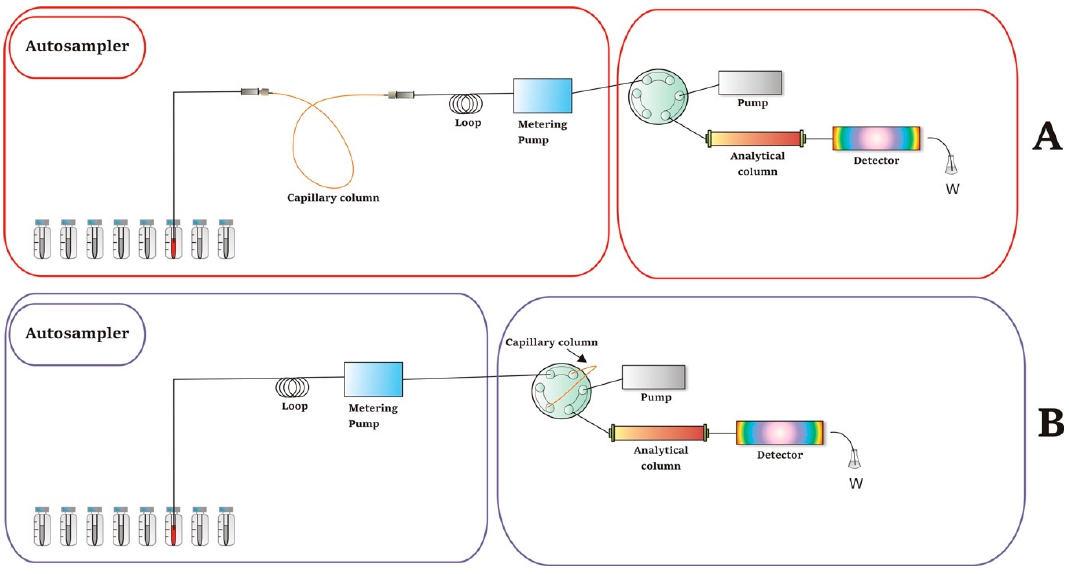
Figure 1. General graphical representation of in-tube SPME setups. ( A ) “Draw-inject” mode; ( B ) “in-valve” mode. It should be noted that the analytical column can be omitted in certain in-tube SPME-MS applications.